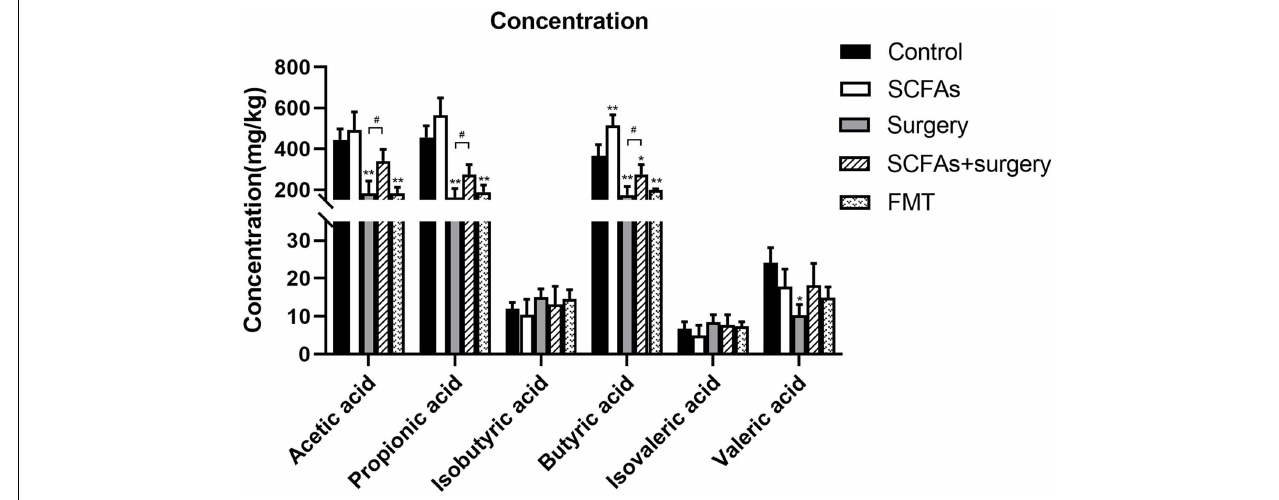
FIGURE 6 | Surgical trauma and anesthesia and fecal microbiota transplantation from surgical mice significantly decreased the levels of straight-chain SCFAs on postoperative day 3 or post-transplantation day 3 compared with the controls. The concentration of straight-chain SCFAs in the surgery group showed significantly less than those in the SCFAs + surgery group. The results are represented as the mean ± SEM. * p < 0.05 vs. the control group, ** p < 0.001 vs. the control group, # p < 0.05 vs. the surgery